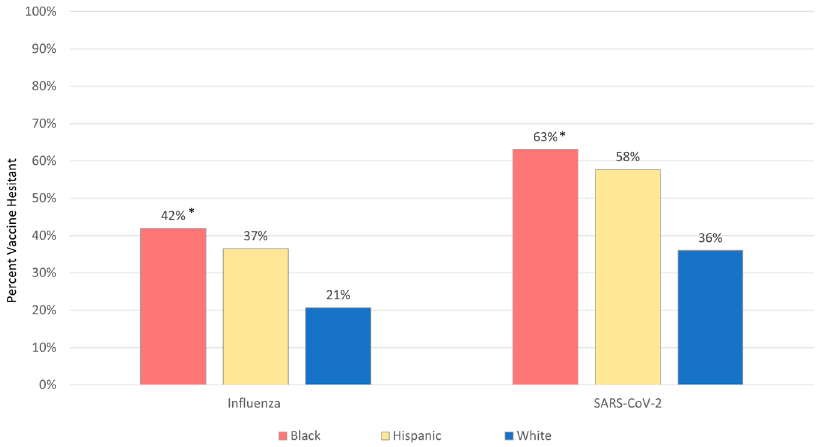
Figure 2. Black Caregivers Report Highest Levels of Vaccine Hesitancy toward Pediatric Influenza and SARS-CoV-2 Vaccines. Pairwise comparisons revealed that Black caregivers were significantly more hesitant to vaccinate children for influenza and SARS-CoV-2 compared to White caregivers. Hispanic caregivers appeared to have greater vaccine hesitancy toward influenza and SARS-CoV-2 than White caregivers, but these did not reach statistical significance. * p < 0.05 compared to White.